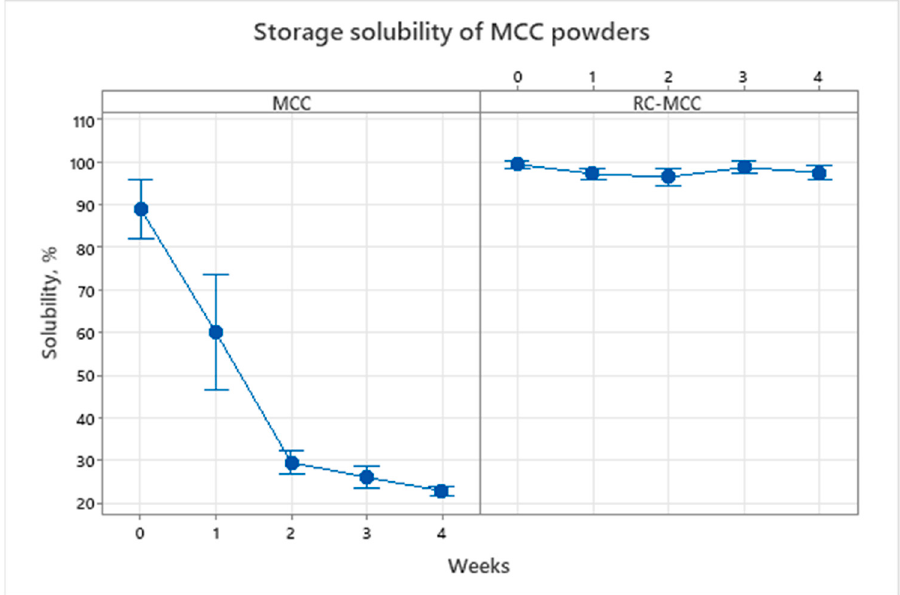
Figure 2. The solubility of MCC and RC-MCC dispersions, stored at 38 ° C for 30 d (four weeks).